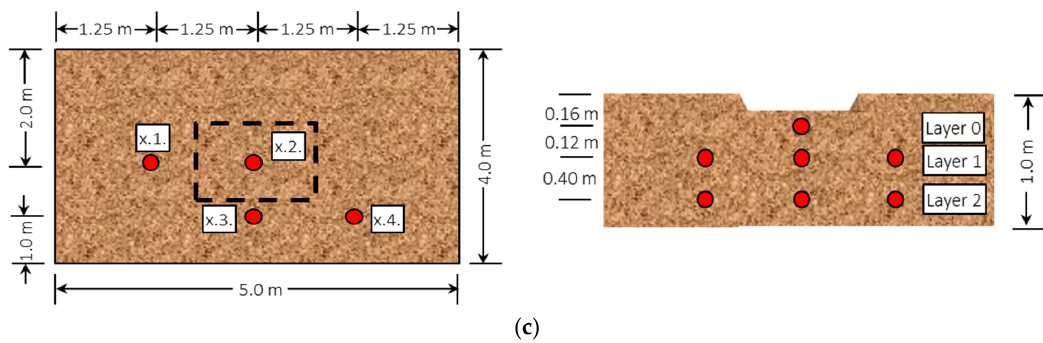
Figure 3. Sketch for the placement of sensors in column ( a ), tank ( b ) and field infiltration unit ( c ). Oxygen probes and suction cups were installed at the same positions in three different depths of 0.16, 0.28 m and 0.68 m to identify possible correlations between soil moisture, oxygen availability as well as soil water quality.